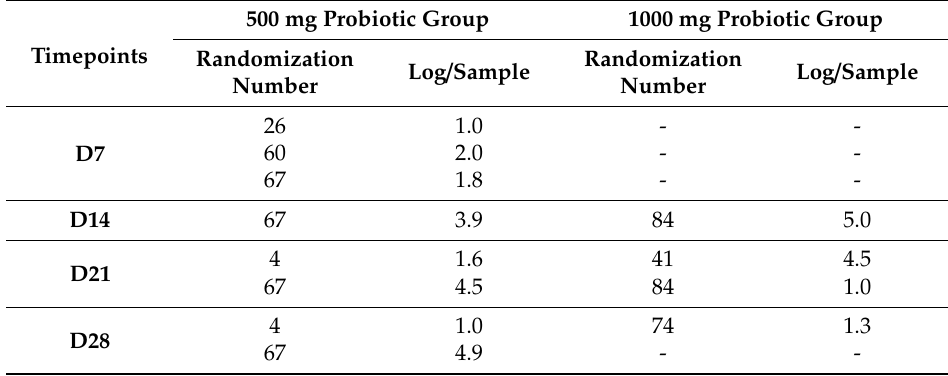
Table 4. Quantification of S. cerevisiae CNCM I-3856 in the vaginal samples positive to the detection of the strain at each study timepoint, expressed as log/sample.